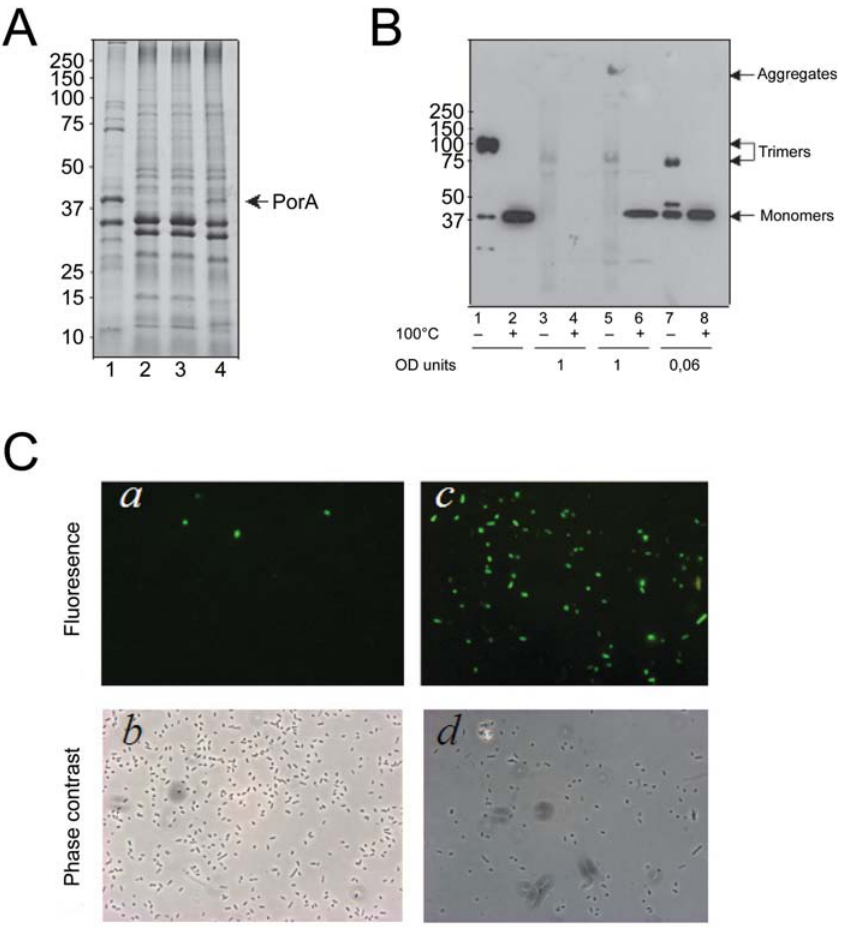
Figure 6. The Species Specificity of OMP Insertion between N. meningitidis and E. coli Is Related to the Nature of the C-Terminal Signature Sequence (A) Coomassie-stained SDS-PAGE gel showing cell envelopes from N. meningitidis strain HB-1 (lane 1), and E. coli containing pCRII-TOPO (lane 2), pII- porAwt (lane 3), or pII- porA-Q (lane 4). (B) Cell envelopes were analyzed by SDS-PAGE after denaturation ( þ ) or without denaturation (–) at 100 8 C as indicated beneath the lanes. The gel was blotted and probed with anti-PorA antibody MN5C11G. Cell envelopes were from N. meningitidis strain HB-1 (lanes 1 and 2), and from E. coli carrying either pCRII-TOPO (lanes 3 and 4), pII- porAwt (lanes 5 and 6), or pII- porA-Q (lanes 7 and 8). Note the different loadings, which are indicated in optical density (OD) units of the original cultures below the blot. In (A) and (B), the E. coli strains were grown with 0.5 mM IPTG, and the positions of molecular mass marker proteins are shown at the left (in KDa). (C) Immunofluorescence microscopy analysis. The binding of a PorA-specific mAb to E. coli Top10F 9 cells expressing wild-type PorA (a) or mutant PorA- Q (c) was evaluated. The corresponding phase-contrast images are shown in (b) and (d) , respectively. DOI: 10.1371/journal.pbio.0030377.g006